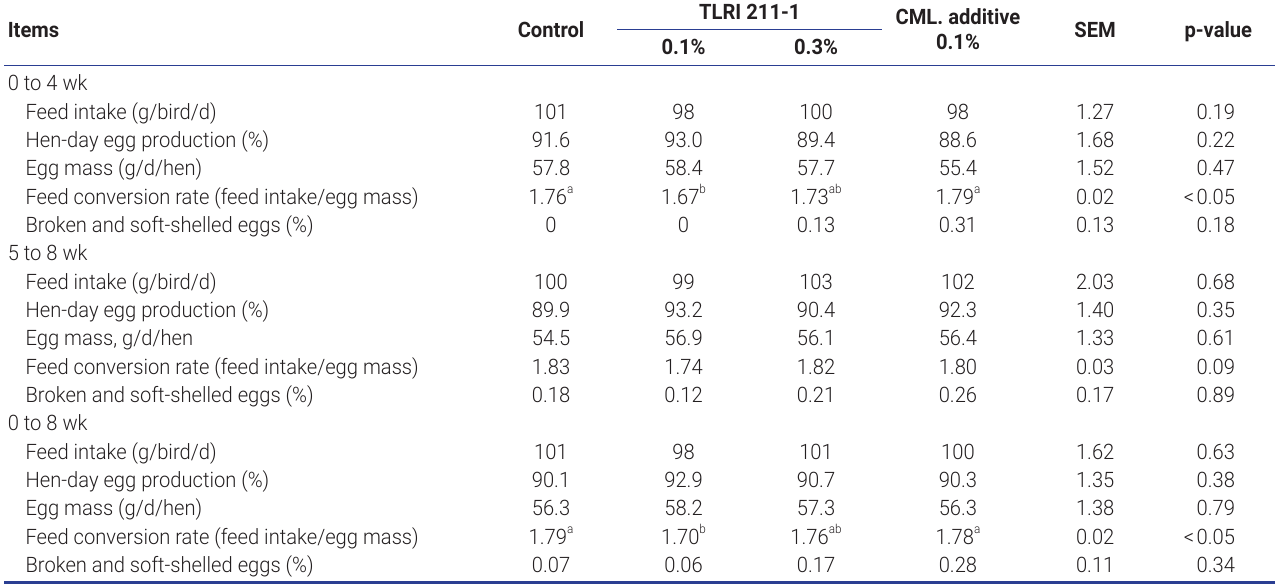
Table 3. Effects of dietary supplementation of Bacillus subtillis and B. amyloliquefaciens on feed intake and egg production performance of Leg- horn laying hens